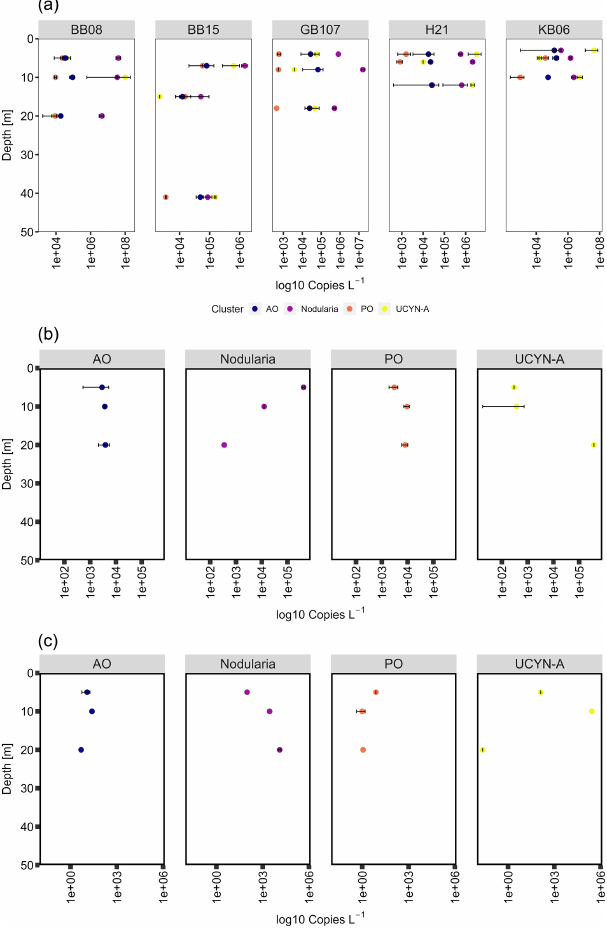
Figure 7. Cluster-specific nifH (a) gene, (b) transcript abundances, and (c) transcript per gene copy of Nodularia , UCYN-A, and gamma PO/AO. In general, both cyanobacterial groups are decreas- ing in nifH gene abundance over depth at all stations. Transcript abundances of Nodularia – nifH were higher in surface waters (5m), contrary to UCYN-A, which showed an opposite trend. Gamma PO/AO gene and transcript abundance generally increased over